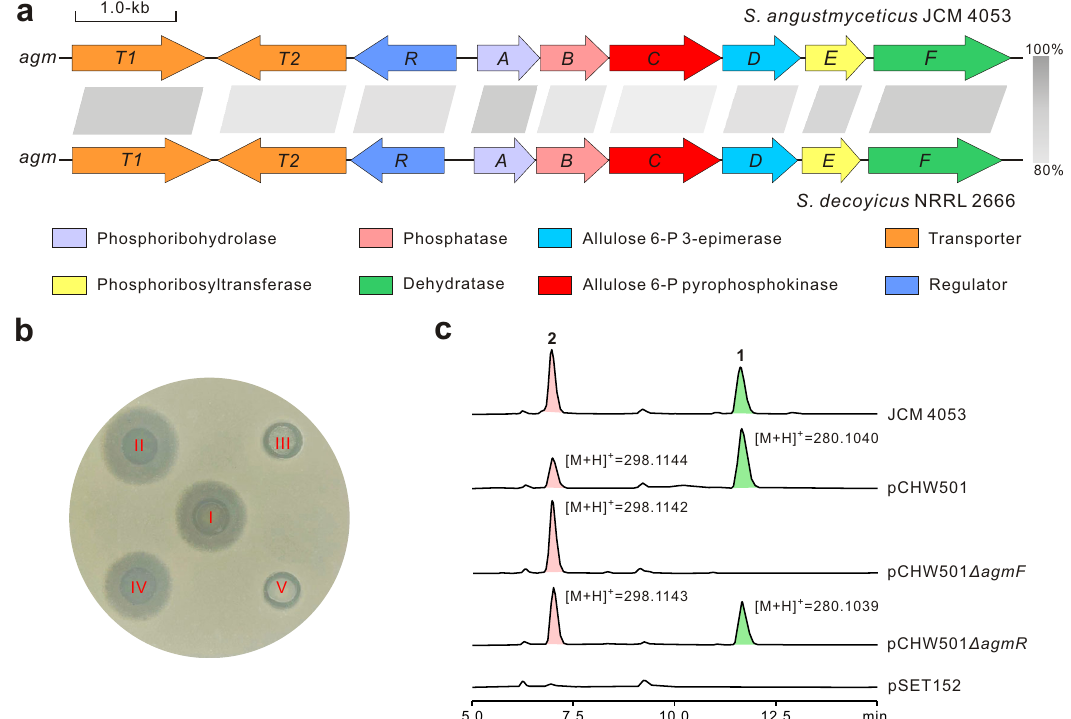
Fig. 2 Genetic organization and veri fi cation of the angustmycin biosynthetic gene cluster. a Genetic organization of the angustmycin biosynthetic gene cluster. The agm gene cluster is responsible for angustmycin biosynthesis in S. angustmyceticus JCM 4053 and S. decoyicus NRRL 2666. The two gene clusters in different strains harbor signi fi cant homologies, and the gray shaded bars represent the identities of the two corresponding enzymes encoded by the two gene clusters. b Bioassays of the metabolites produced by related recombinants of S. coelicolor M1154. The indicator strain is Mycobacterium smegmatis mc 2 155. The Roman numerals I, II, III, IV, and V represent JCM 4053, pCHW501, pCHW501 Δ agmF , pCHW501 Δ agmR , and pSET152, respectively, and the denotations of them correspond to those shown in ( c ). c HPLC analysis ( λ = 254 nm) of the metabolites produced by related recombinants of S. coelicolor M1154. JCM 4053, 1 and 2 produced by S. angustmyceticus JCM 4053 as positive controls ; pCHW501, the metabolites of